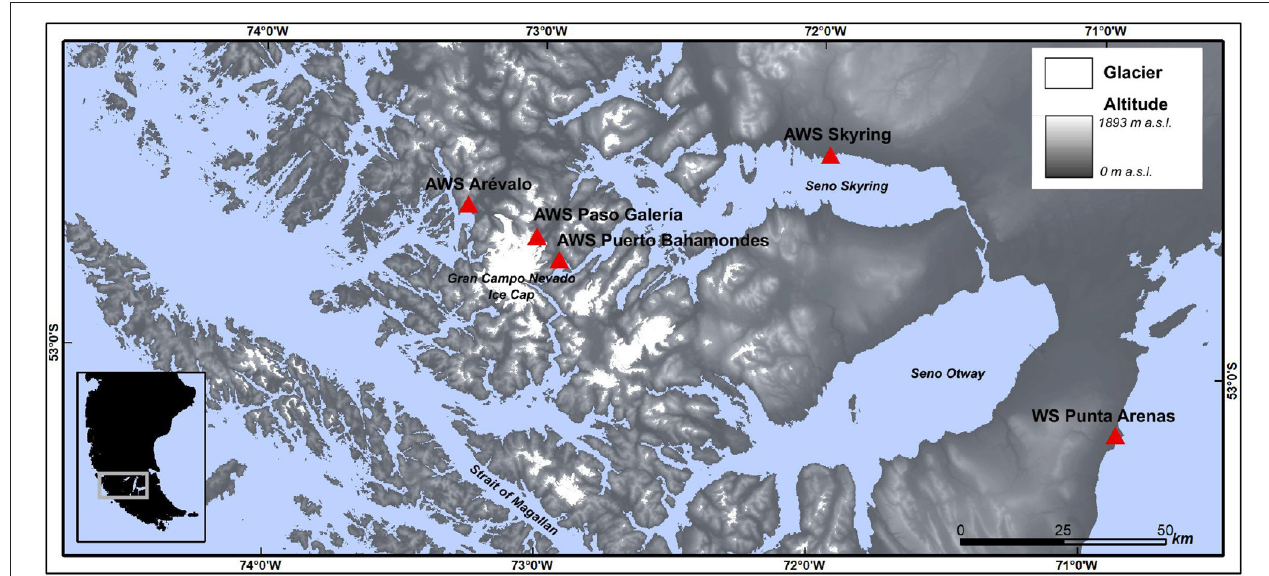
FIGURE 1 | Location of automatic weather stations (AWS) at the Gran Campo Nevado Ice Cap and the weather station (WS) at Punta Arenas. Glacier outlines are based on the Randolph Glacier Inventory 6.0.